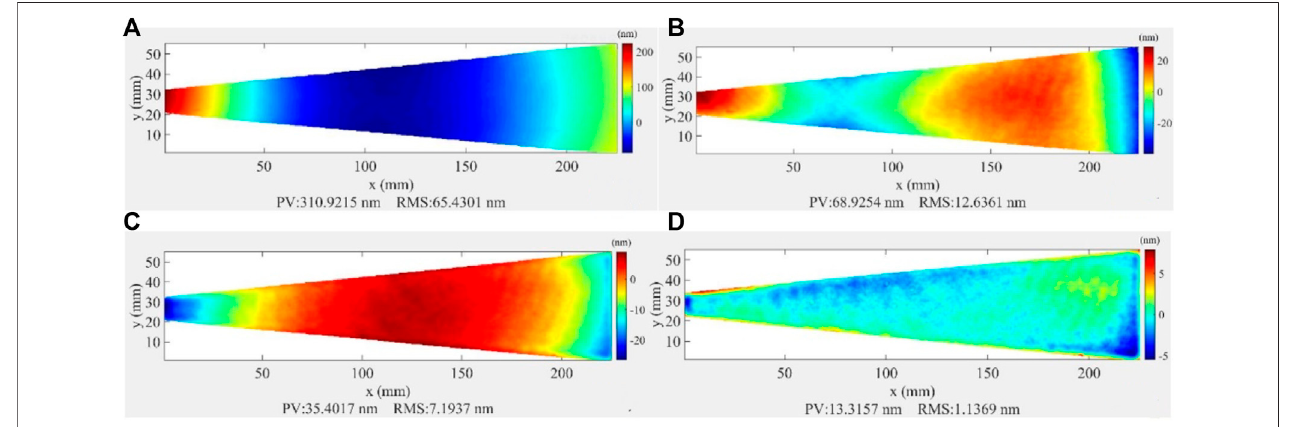
FIGURE 5 | RMS values of two-dimensional slope errors of VFM calculated at different spatial